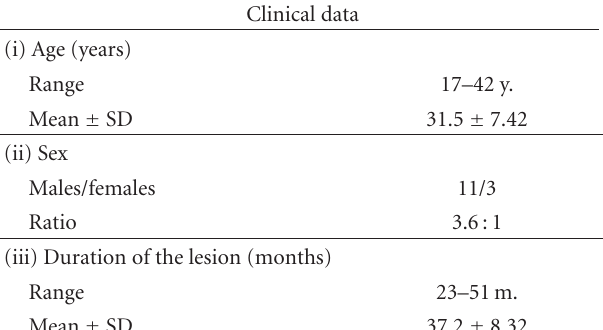
Table 1: The clinicopathological and immunohistochemical fea- tures of ulcerative